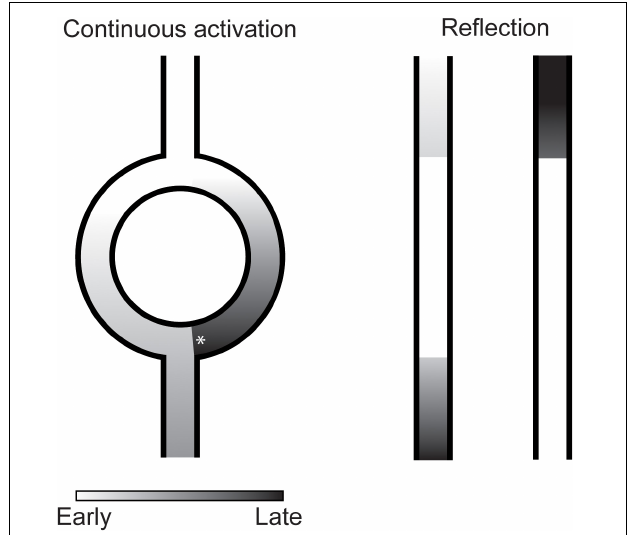
FIGURE 3 | Illustration of continuous activation (left) and reflection (right) as mechanism of premature ventricular complexes. In continuous activation, a second activation front traveling through a separate pathway reactivates the myocardium. This separate pathway activates in only one direction which requires unidirectional block (asterisk) at the distal site. Furthermore, sufficient activation delay is required over this pathway to reactivate the myocardium after its refractory period. In reflection, activation delay over an inexcitable gap is sufficiently long for the myocardium to recover from refractoriness resulting in reactivation of the proximal